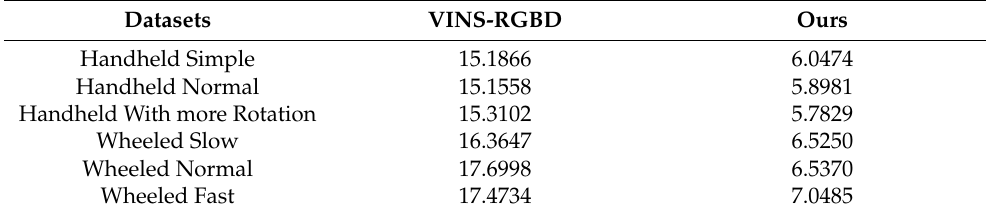
Table 5. Time of VIO front-end per frame comparisons between two different methods in milliseconds.